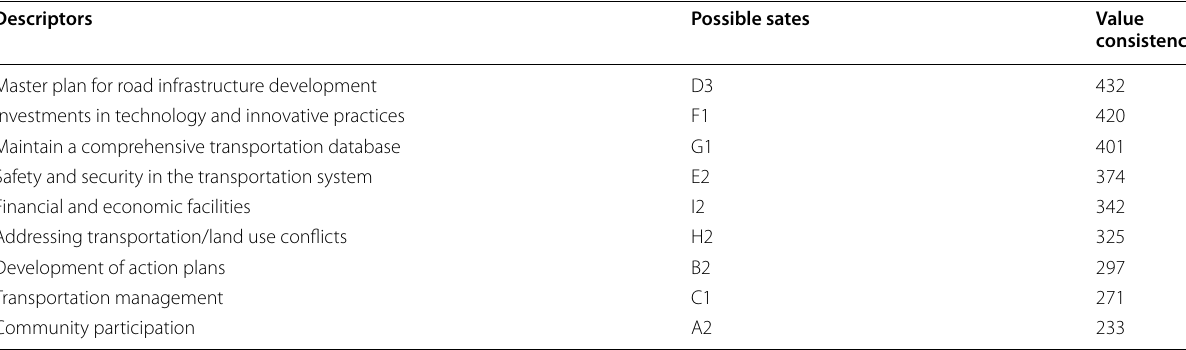
Table 6 Each possible state’ value